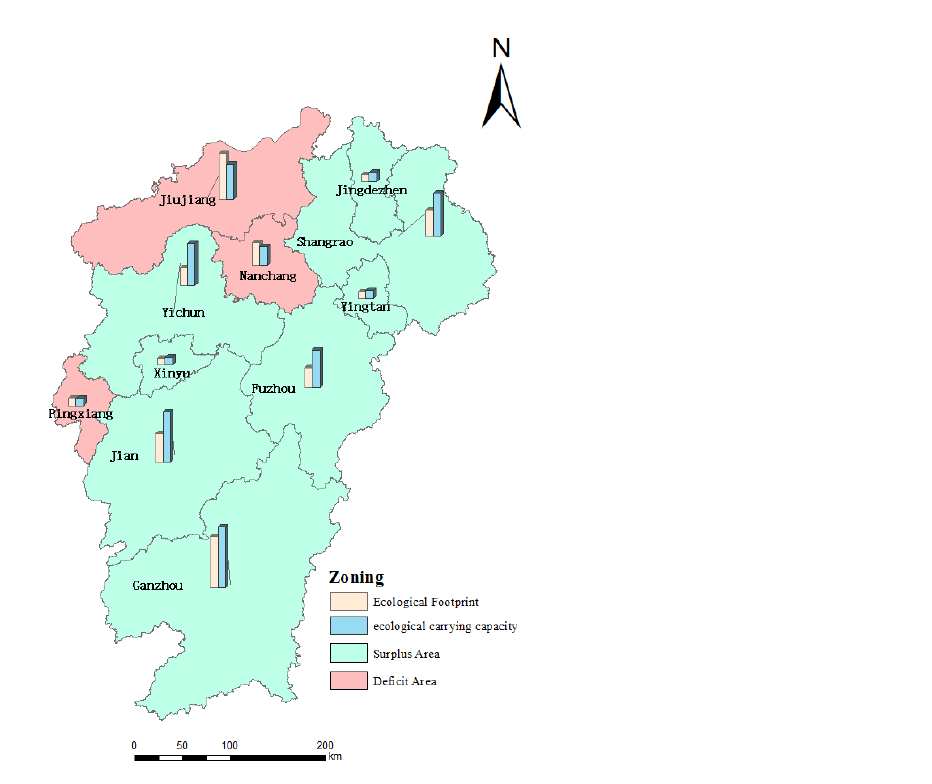
Figure 3. Spatial distribution of ecological surplus of cultivated land resource assets. 3.3. The Results of Horizontal Ecological Compensation Values for Cultivated Land in Jiangxi The values of horizontal ecological compensation for cultivated land in the 11 cities of Jiangxi province were calculated according to Formula (17). From the amount of eco- logical compensation perspective, the three cities with the highest amount of ecological compensation were Ganzhou, Shangrao and Ji’an, and the total amount of compensation in these cities is CNY 25.14 billion, making up about 50.83% of the horizontal ecological compensation values of all cities in Jiangxi, as shown in Figure 4. From the values of ecological profit and loss perspective, payment districts are either the districts with relatively small amounts of farmland and ecological carrying capacity, such as Pingxiang (CNY − 1.09 billion) and Nanchang (CNY − 1.52 billion), or the districts in which the ecological footprint is relatively higher, e.g., Jiujiang (CNY 5.33 billion). Meanwhile, other cities were the ecological compensation zones, and the total values of ecological compensation in these cities (CNY 41.52 billion) is nearly 5.5 times of the total payment values (CNY 7.45 billion). The reasons for the results are mainly attributed to the calculation method of hori- zontal ecological compensation based on an improved ecological footprint model, and the ecological supply capacity of cultivated land in Jiangxi was much above the national average. However, because it is difficult to achieve the absolute equilibrium of horizontal ecological compensation for cultivated land within Jiangxi province, the difference between compensation and payment should be made up for by the central and provincial